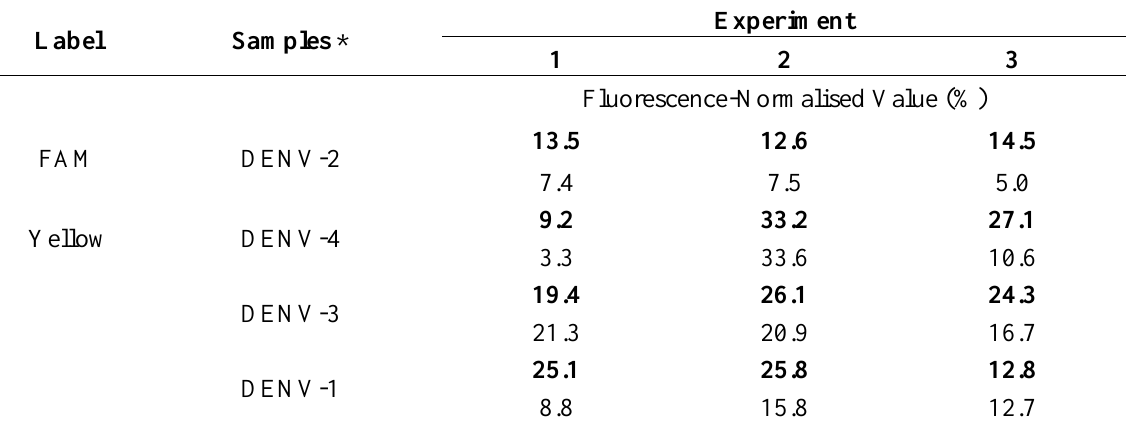
Table 5. Variability coefficient (%) of sample fluorescence in the